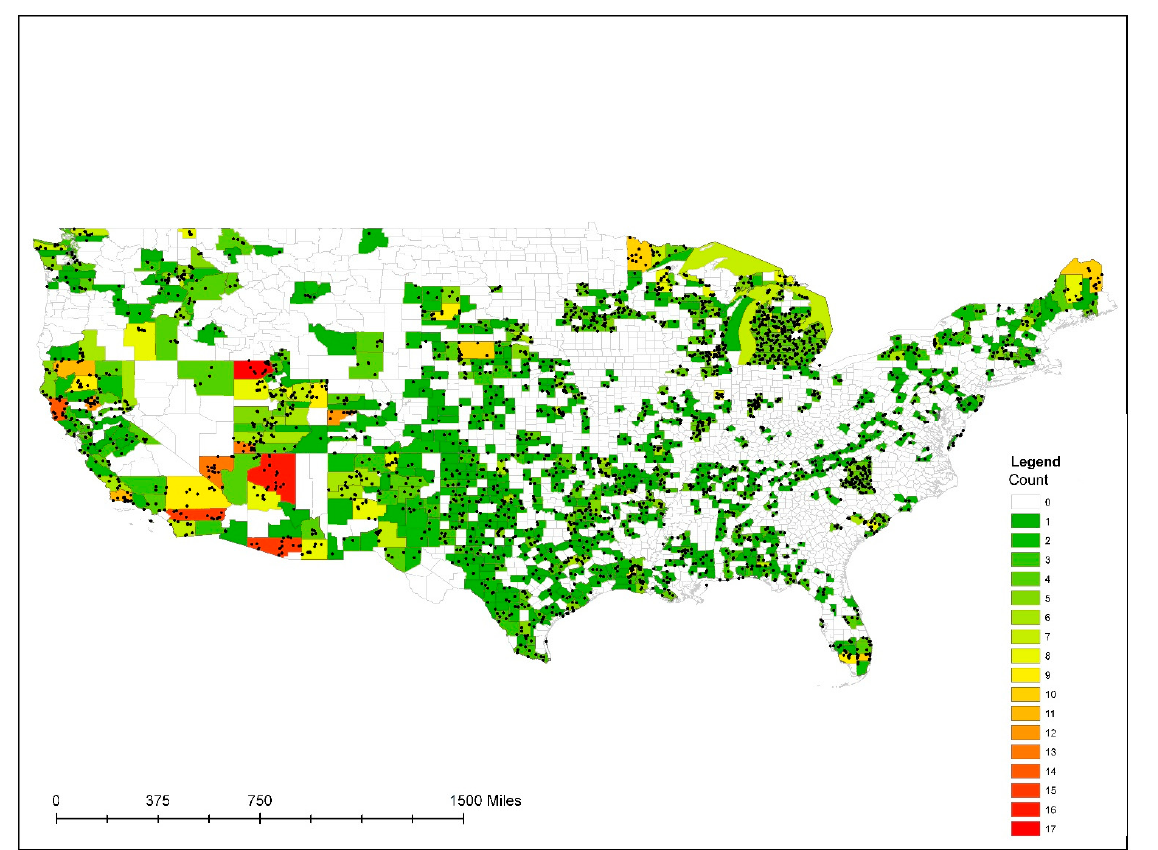
Figure 2. Location of individual stratified random sample files (black points), with a choropleth map showing number of files by county.